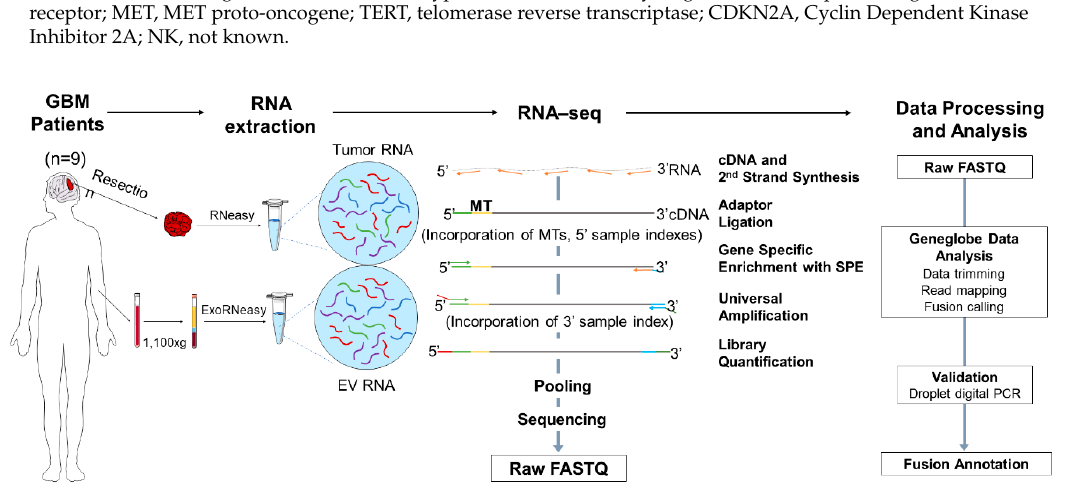
Figure 1. Overview of RNA-seq-based gene fusion discovery workflow. The RNA was extracted from the tumor tissue and matched plasma of patients with glioblastoma (GBM) ( n = 9) and plasma of healthy controls ( n = 10) and was sequenced using the QIAseq Targeted RNAscan Human Oncology Panel. Schematic illustration of the workflow depicting the RNA extraction, library preparation, sequencing, data processing, analysis and final validation using droplet digital PCR and fusion annotation. GBM, glioblastoma; EV RNA, extracellular vesicle RNA; MT, molecular tag; SPE, single primer